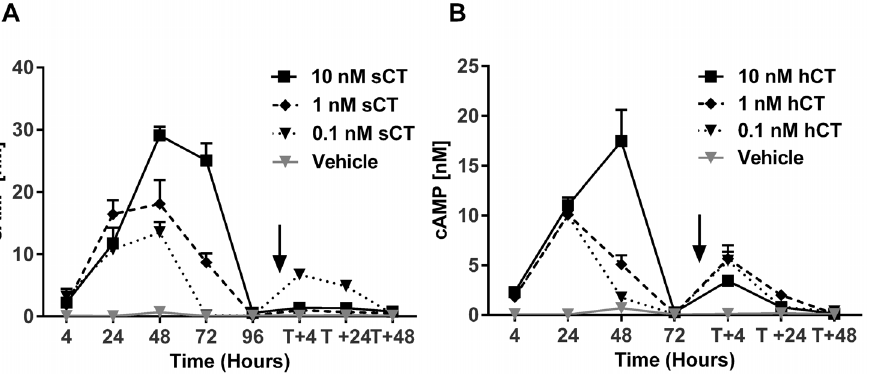
Figure 6. Continuous stimulation attenuates additional prolonged responses in inverse proportion to ligand concentration. U2OS CALCR cells were stimulated with sCT for 4, 24, 48, 72 or 96 hours (A) or hCT for 4, 24, 48 or 72 hours (B) in a similar prolonged setup as demonstrated in Figure 2. In parallel, one set of cells was stimulated for 96h (sCT) or 72h (hCT), following which the culture medium was replaced with fresh medium with ligands and incubated for another 4, 24 or 48 hours. Ligand concentration sCT or hCT: 10 nM, 1 nM, 0.1 nM or vehicle. The vertical arrow indicates time of medium-ligand replacement.